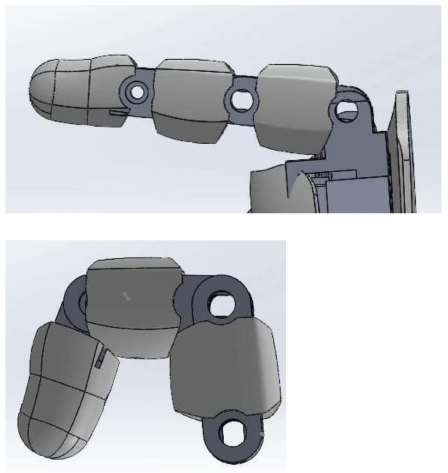
Figure 4. Simulation of the angular displacement on the example of the index